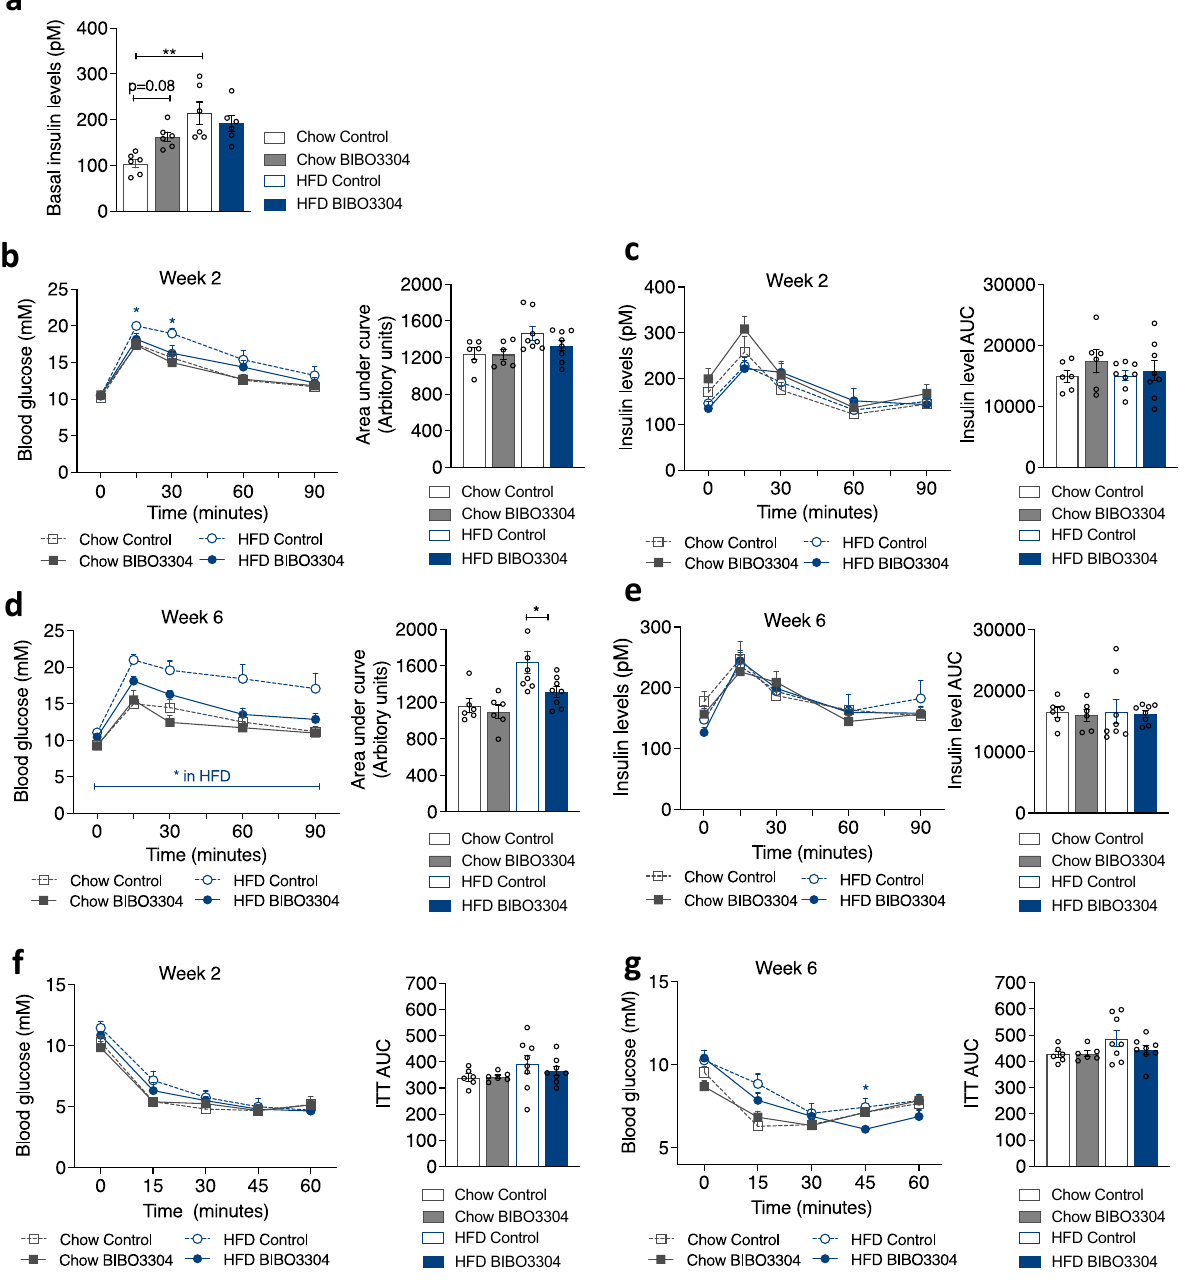
Fig. 3 Effect of peripheral Y1R antagonism on glucose homeostasis. a Blood insulin levels under fed condition in chow- or HFD-fed wild-type mice given either a chow or a HFD at 13 – 14 weeks of age. Data are mean ± s.e.m, n = 6 per group (chow, control: open grey bar; BIBO3304: grey bar. HFD, control: open blue bar; BIBO3304: fi lled blue bar). * p < 0.05, ** p < 0.01, one - way ANOVA with Tukey ’ s multiple comparisons test. Glucose levels in intraperitoneal glucose tolerance tests (GTT) in chow- or HFD-fed wild type mice after 2 ( b ) and 6 weeks ( d ) daily treatment with vehicle or BIBO3304, and corresponding area under the curve (AUC) analysis of glucose over time in these mice. c , e , Insulin levels throughout the GTTs 2 and 6 weeks post treatments in ( b , d ) and corresponding AUC analysis for these mice. f , g , Glucose levels in an insulin tolerance test (ITT) conducted after 2 and 6 weeks daily treatment with either vehicle or BIBO3304, and corresponding AUC analysis for the mice in ( f , g ). Data are mean ± s.e.m, chow n = 6 (control: open grey; BIBO3304: grey), HFD n = 8 (control: open blue; BIBO3304: blue), * p < 0.05, two-way repeated measures ANOVA with Sidak ’ s multiple comparisons test. Source data are provided as a Source Data fi by reduced heat loss. As the tail is regarded as a major thermo- temperature was examined. Interestingly, in contrast to chow-fed regulatory organ in heat dissipation in rodents, and an increase in mice, BIBO3304-treated DIO mice showed a signi fi cant increase tail skin temperature is indicative of an increase in heat loss 18 , tail in tail temperature compared to control DIO mice (Fig. 4f),